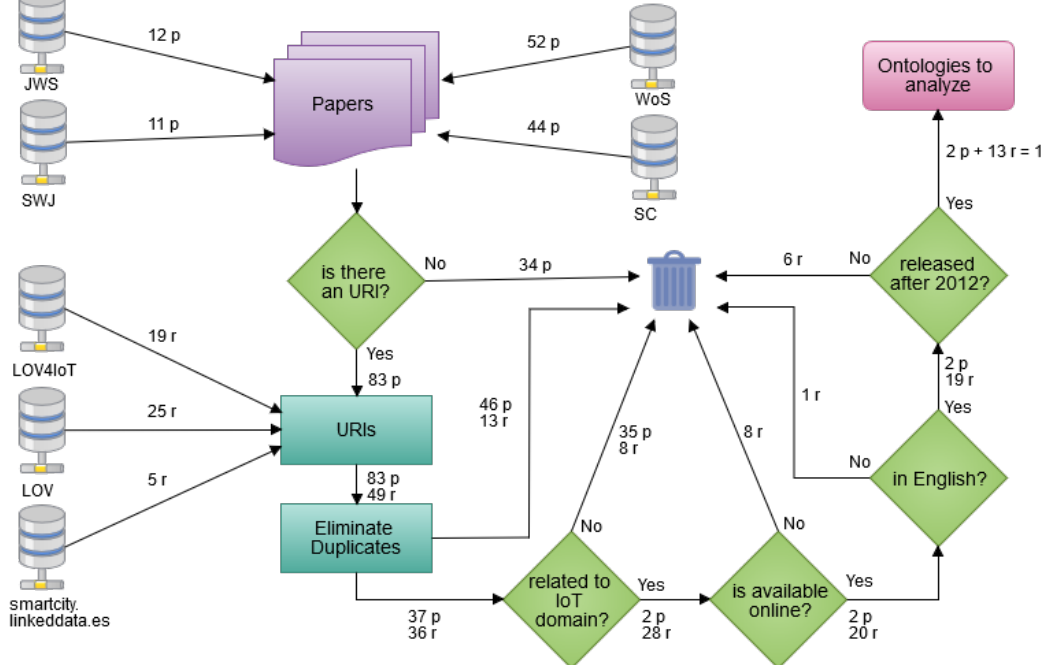
Figure 2. Systematic literature review workflow with the detail of the number of studies found. Numbers followed by letter “p” refer to publications results from databases and journals, and those followed by letter “r” refer to ontology registries’